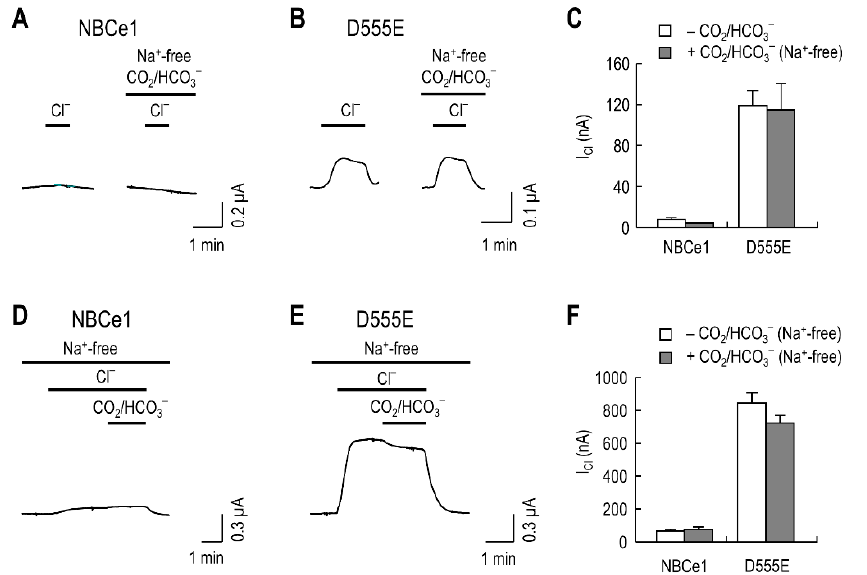
Figure 2. D555E-mediated I Cl is produced in Na + -free CO 2 /HCO 3 − solution. ( A , B ) Representative I Cl produced by NBCe1 and D555E. Recording I Cl was performed in the absence of CO 2 /HCO 3 − and then repeated in Na + -free solution equilibrated with 5% CO 2 , 25 mM HCO 3 − . ( C ) Mean I Cl , produced by NBCe1 and D555E, in the absence of CO 2 /HCO 3 − vs. the presence of Na + -free CO 2 /HCO 3 − ( n = 5 NBCe1 and 10 D555E). ( D , E ) Effects of Na + -free CO 2 /HCO 3 − on I Cl , produced by NBCe1 and D555E. I Cl was measured before and after CO 2 /HCO 3 − was applied. All solutions lacked Na + . ( F ) Mean I Cl before and after application of CO 2 /HCO 3 − under the Na + -free condition ( n = 5/group). The holding potential was − 60 mV in all experiments.